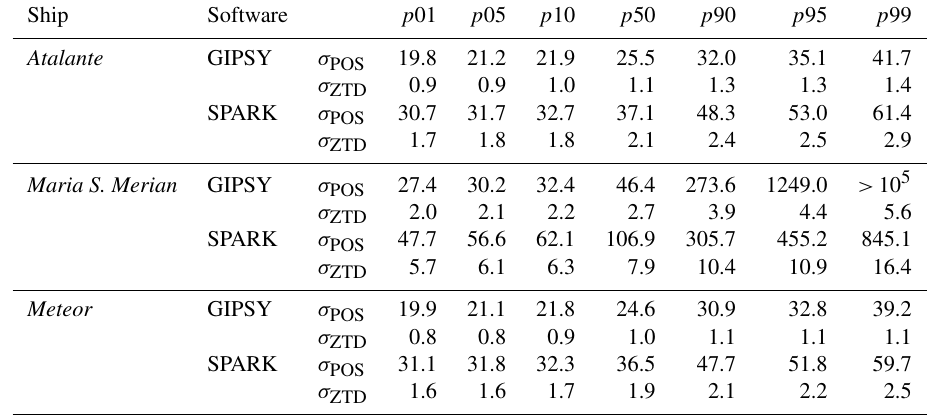
Figure 4. Formal errors for position ( σ POS ) and ZTD ( σ ZTD ) estimates for the three R/Vs, from top to bottom: Atalante , Maria S. Merian , and Meteor . (a–c) GIPSY processing. (d–f) SPARK processing. Horizontal coloured lines indicate values for the 1st, 5th, 10th, 90th, 95th and 99th percentiles. Table 3. Percentile ( p ) values for formal errors in position ( σ POS ) and ZTD ( σ ZTD ), in millimetres, for GIPSY and SPARK processing.